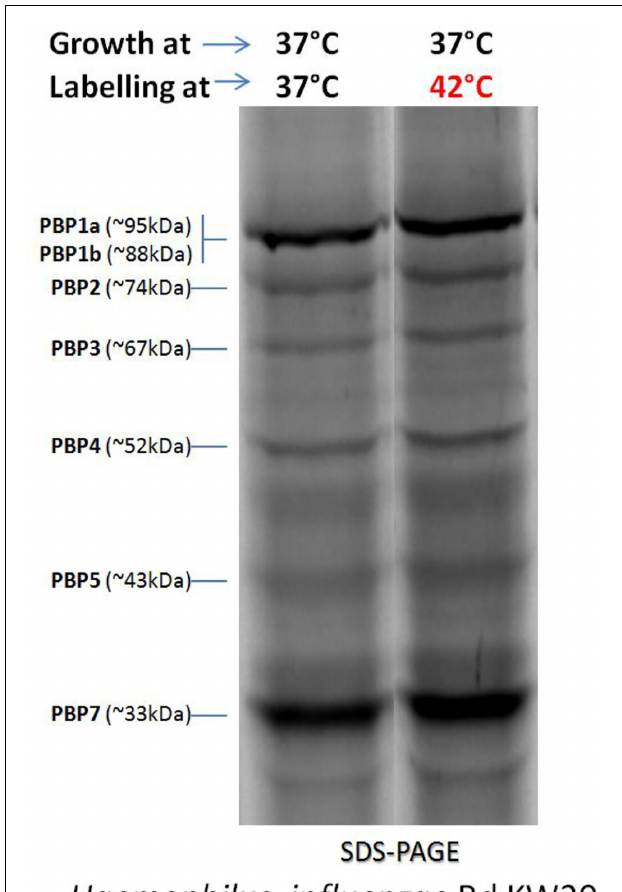
FIGURE 5 | Bocillin-FL binding to PBPs of the reference H. influenzae strain Rd KW20 at two different labeling temperatures (37 or 42 ◦